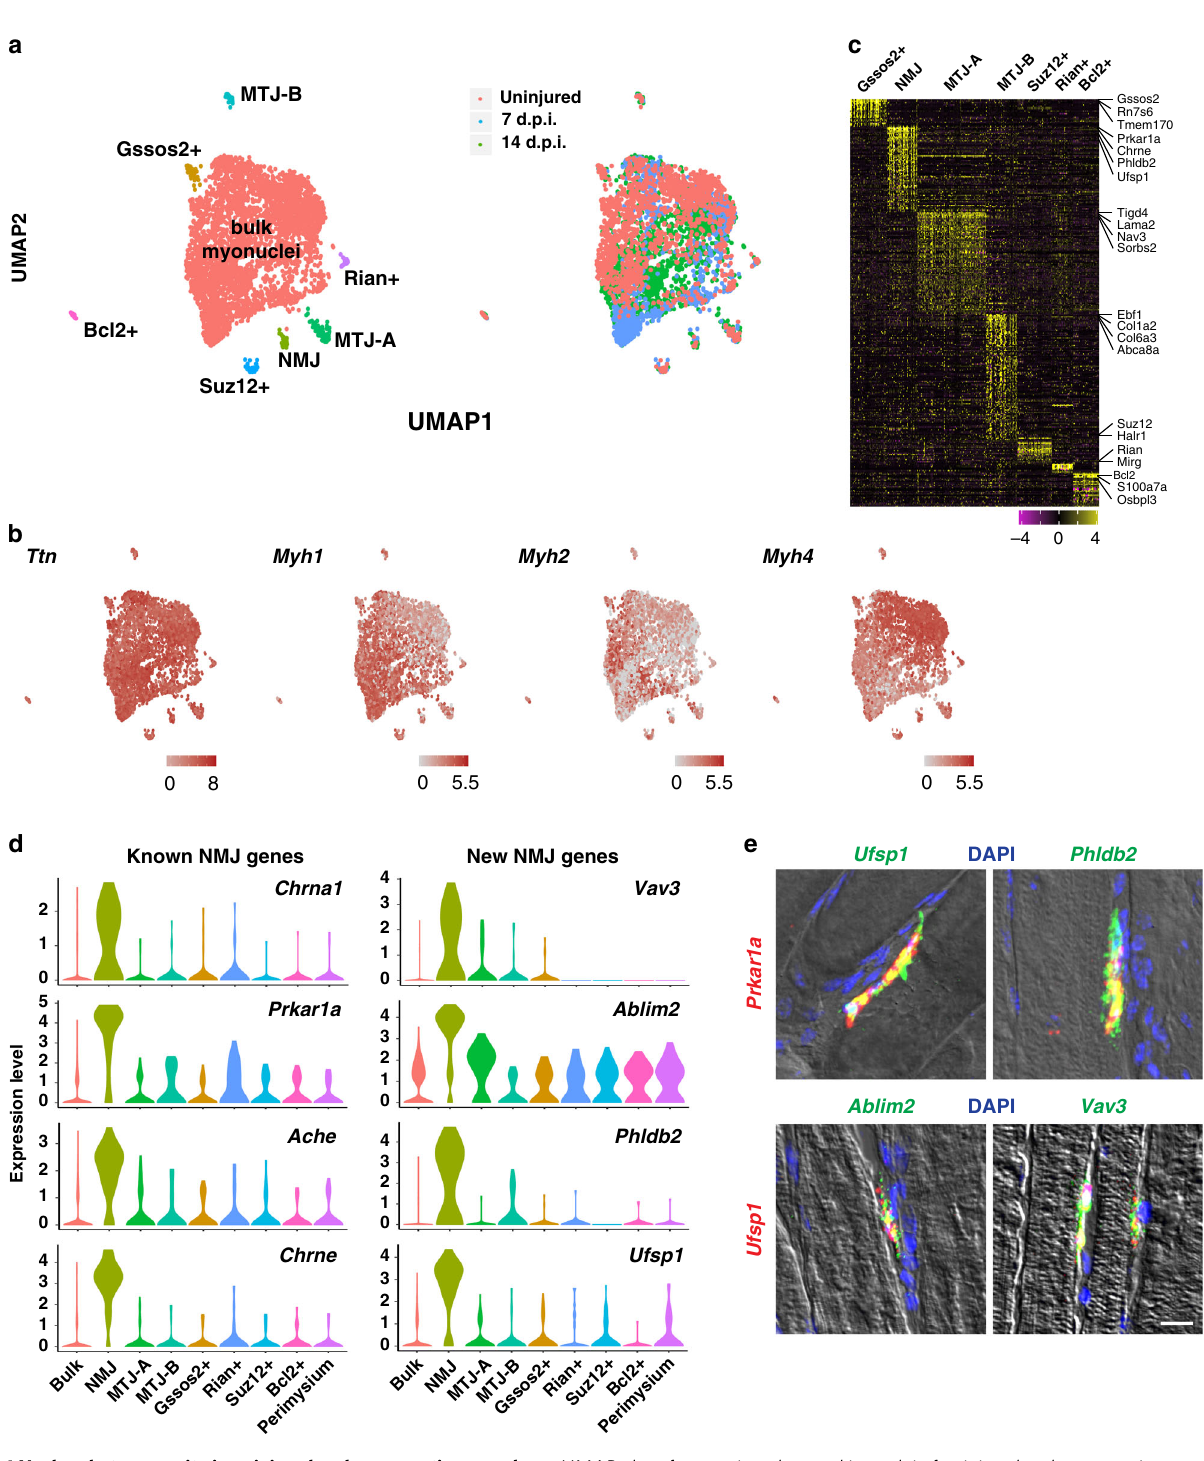
Fig. 1 Nuclear heterogeneity in uninjured and regenerating muscles. a UMAP plot of transcripts detected in nuclei of uninjured and regenerating muscles. The colors identify different nuclear populations (left) or nuclei in uninjured or regenerating muscle (right). The perimysium population is identi fi ed after re-clustering the bulk myonuclei and described further in Fig. 3. b Expression of Ttn and Myosin genes identi fi es myonuclei. c Heat-map of speci fi c genes enriched in clusters other than the bulk myonuclei. Top representative genes are indicated on the side. d Violin plots of the previously known or NMJ marker genes identi fi ed here. e Upper row — conventional FISH against a known NMJ marker ( Prkar1a ) and NMJ genes identi fi ed here (green). Bottom row — single-molecule FISH against Ufsp1 (red) and other newly identi fi ed NMJ genes (green). Expression patterns were validated in two or more individuals. Scale bar, 10 µ